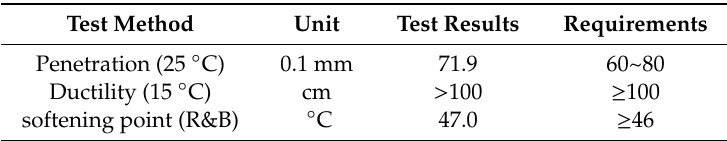
Table 1. Properties of AH-70